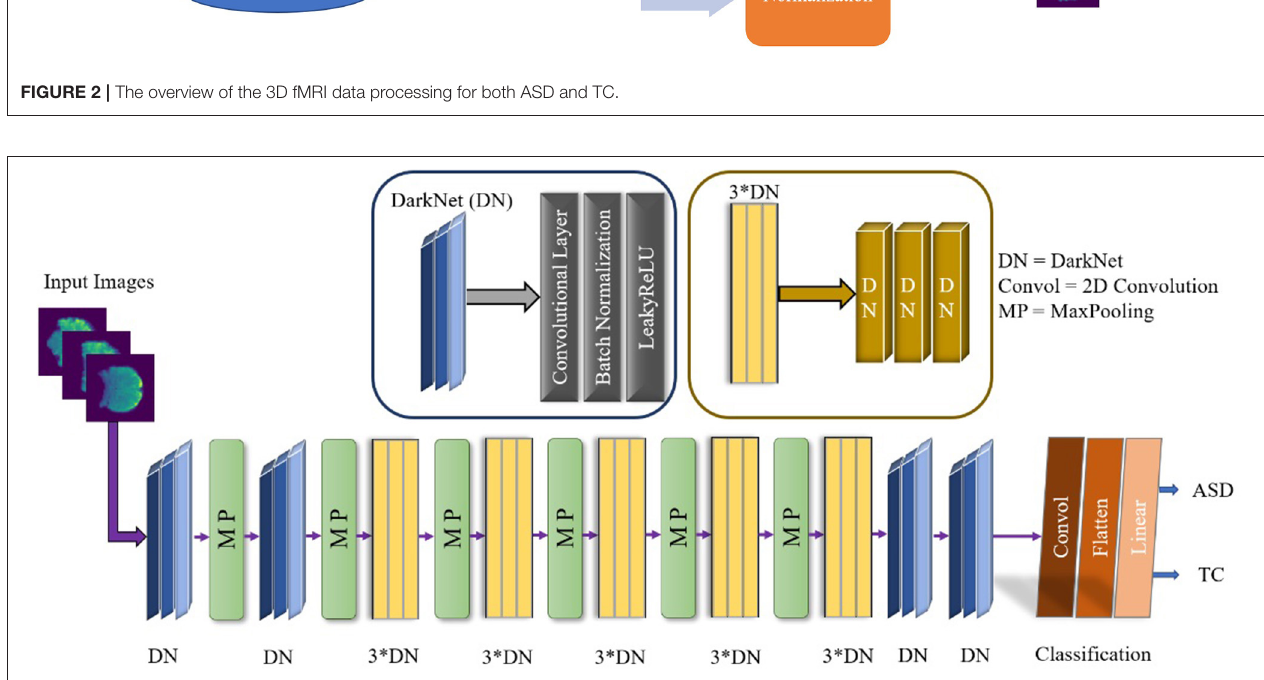
FIGURE 3 | The proposed DarkASDNet framework for ASD